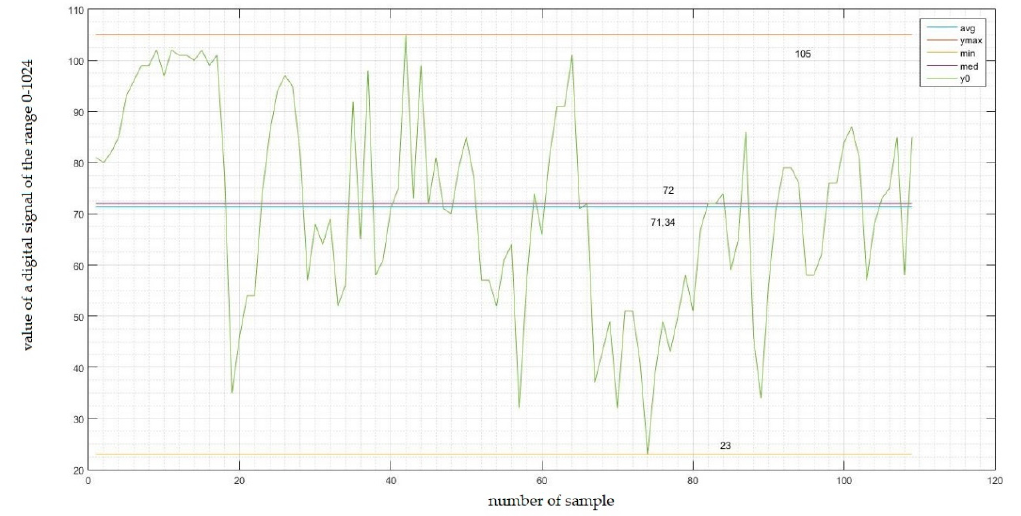
Figure A2. Data from the sensor on a straight thumb.